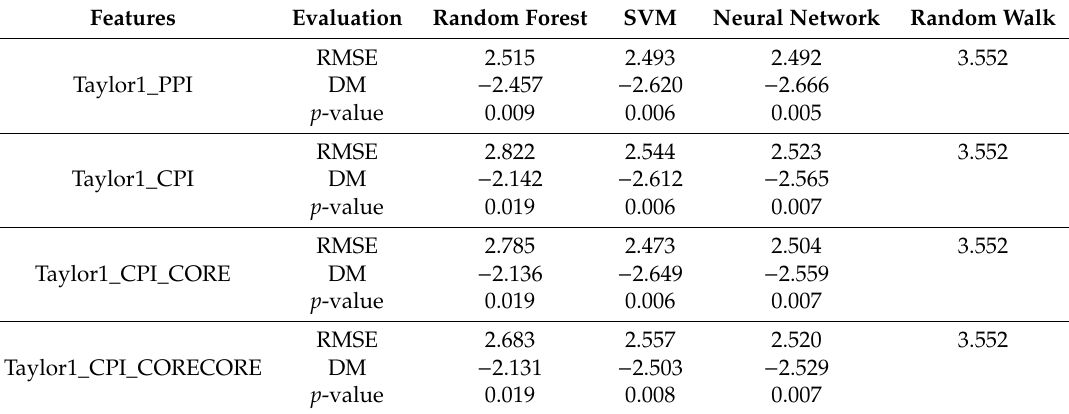
Table 5. Results for the Taylor model (Equation